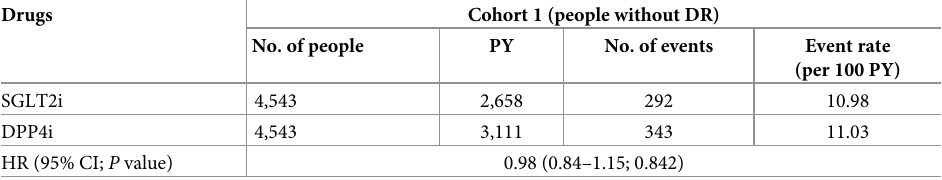
Table 3. Sensitivity analysis for the prevalence of ICD code-defined DR among the subjects that ever had the pro- cedure codes for fundus examination. Drugs Cohort 1 (people without DR) No. of people PY No. of events Event rate (per 100 PY) SGLT2i 4,543 2,658 292 10.98 DPP4i 4,543 3,111 343